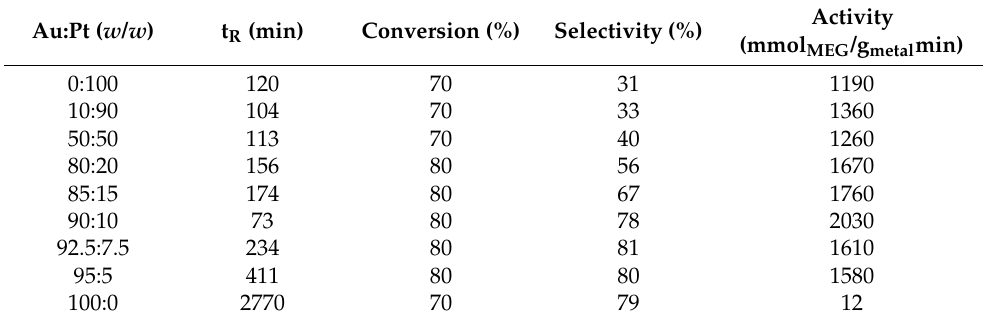
Table 1. Influence of the nominal gold/platinum ratio on the activity (calculated between 0 and 40% conversion) and selectivity of the catalyst in the oxidation of MEG to GA at reaction time t R at 70 and 80% MEG conversion respectively. Reaction conditions: 20 wt% MEG, 70 ◦ C, 25 g/L 0.1 wt% AuPt/CeO 2 , pH 10.5, 7 bar O 2